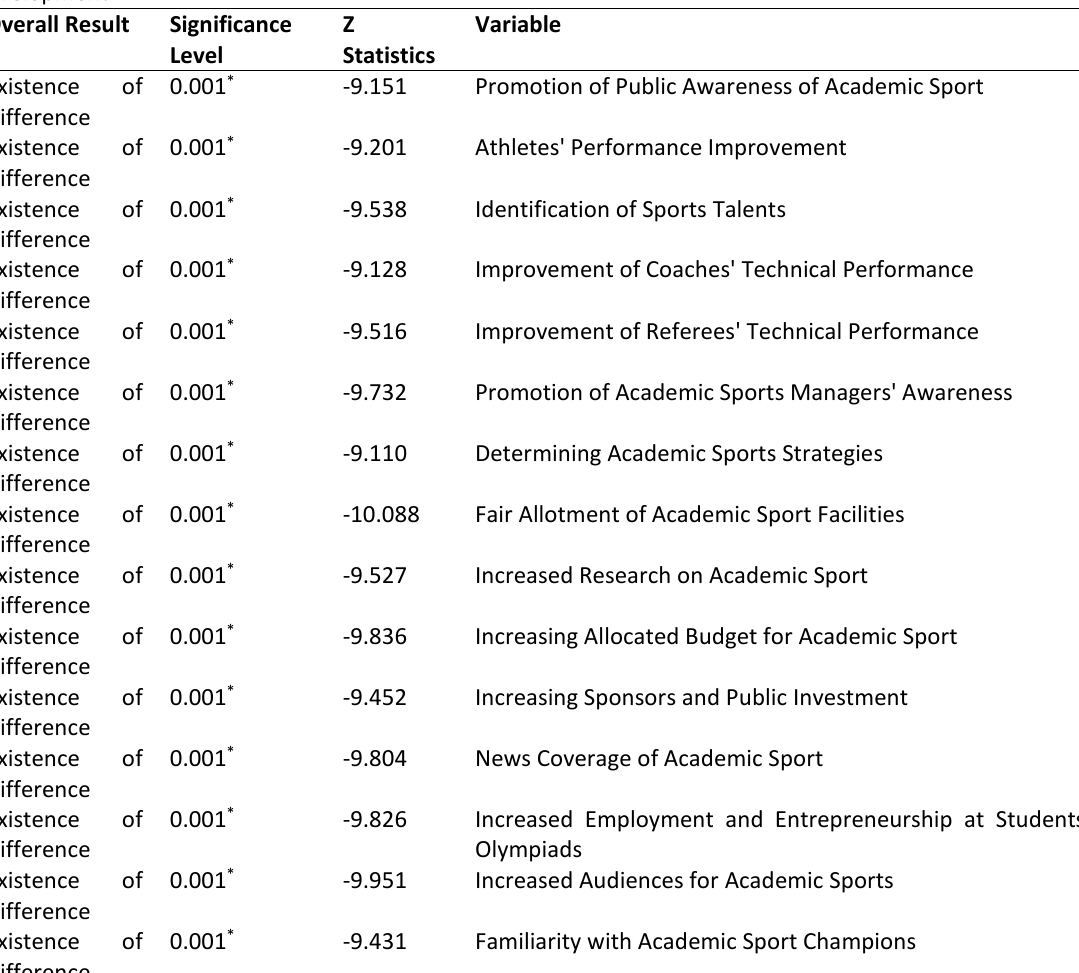
Table 2. Comparison of Current Situation and Desirable Role of Mass Media in Female Academic Sports